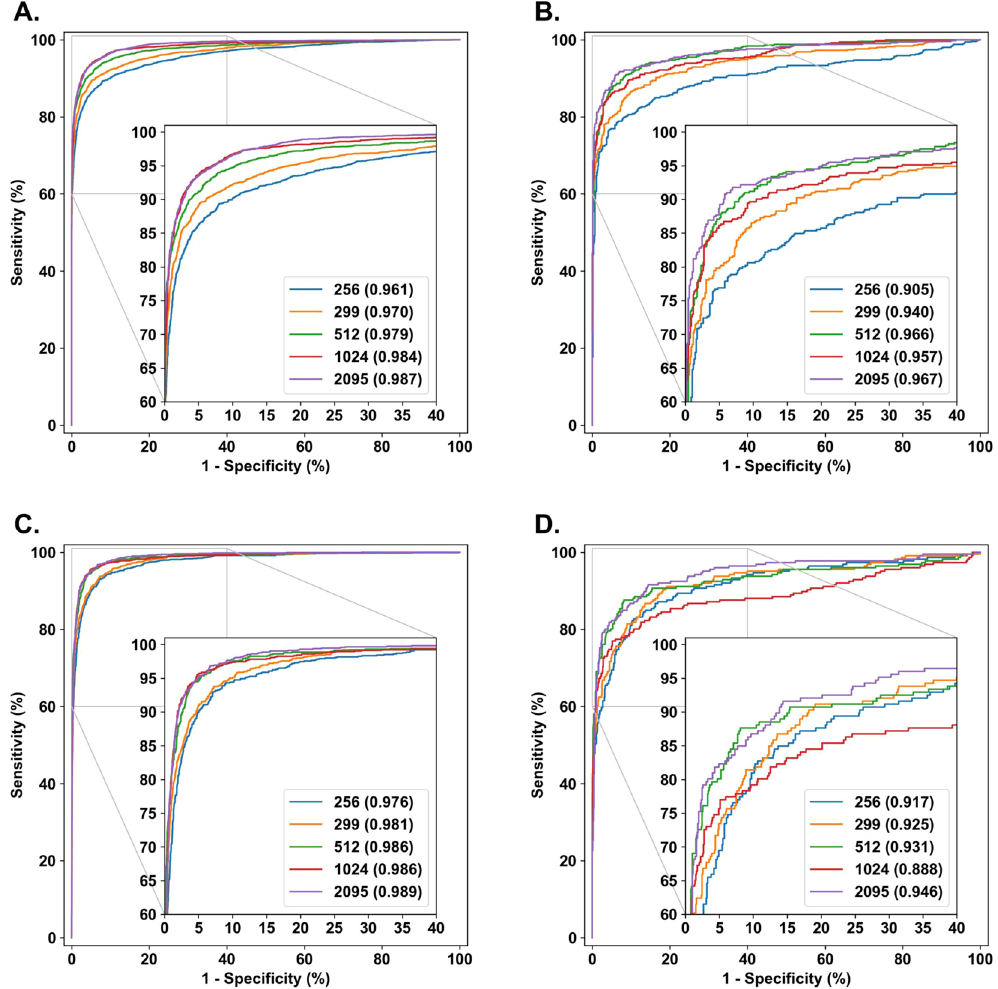
Figure 1. ROC curves for nonreferable vs. referable diabetic retinopathy in classifying nonreferable vs. referable macular edema on primary validation set and Messidor set. ( A) NRDR/RDR classification on the primary validation set (N = 7118). ( B) NRDR/RDR classification on Messidor set (N = 1200). ( C) NRDME/ RDME classification on the primary validation set (N = 7304). ( D ) NRDME/RDME classification on Messidor set (N = 1200). Referable vs. nonreferable diabetic retinopathy shown in ( A,B ) and referable diabetic macular edema shown in C and D. ROC curve is shown for input image sizes of 256 × 256, 299 × 299, 512 × 512, 1024 × 1024 and 2095 × 2095 pixels. AUC shown in parentheses in the